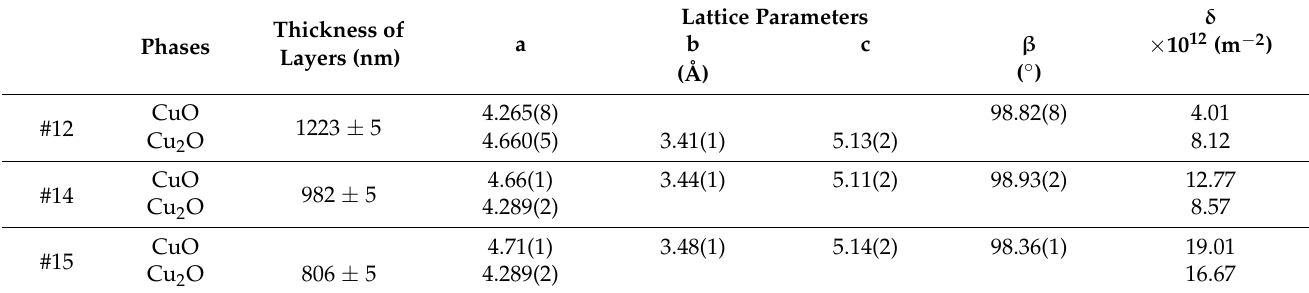
Table 3. Structural parameters of TiO 2 /CuO/Cu 2 O thin films.